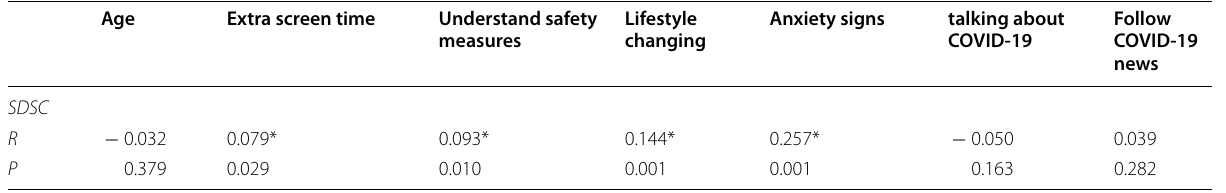
Table 7 Correlation between sleep disorder score and other lifestyle